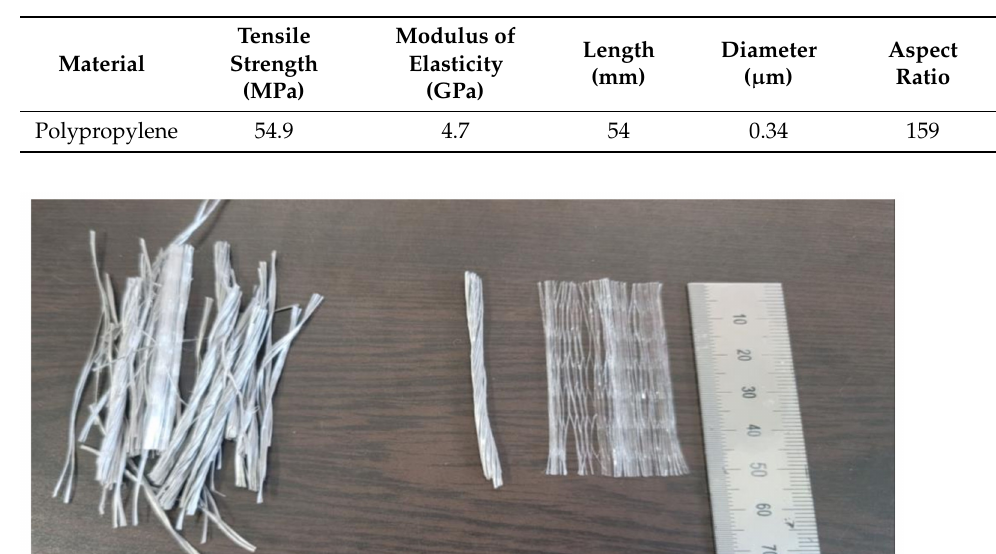
Table 2. Fiber specifications [2,3].